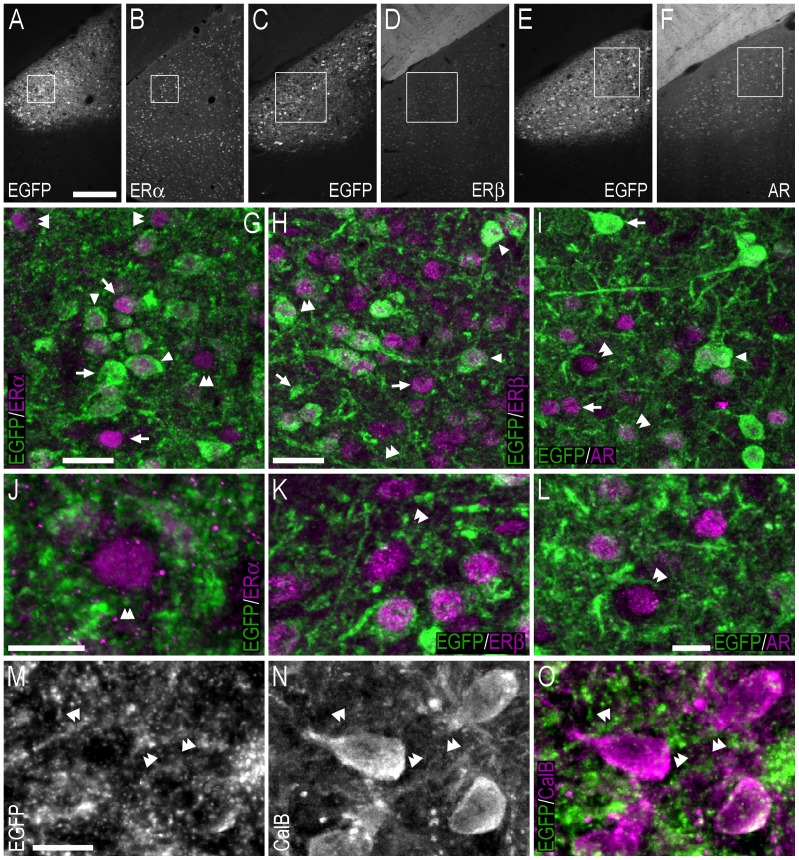
Double-immunofluorescence photo and confocal micrographs showing the distribution of EGFP−, ERα−, ERβ- AR- and calbindin-LI in the medial amygdaloid nucleus – posterodorsal (MePD) part.(A, B) Single-channel photomicrographs of double-fluorescence immunohistochemistry, showing EGFP− (A) and ERα-LI (B) (Bregma, −2.06 mm). (C, D) Single-channel photomicrographs of double-fluorescence immunohistochemistry, showing EGFP− (C) and ERβ-LI (D) (Bregma, −2.06 mm). (E, F) Single-channel photomicrographs of double-fluorescence immunohistochemistry, showing EGFP− (E) and AR-LI (F) (Bregma, −2.06 mm). (G–I) Confocal micrographs of double-immunofluorescence histochemistry displaying (G) EGFP− (green) and ERα-LI (magenta), (H) EGFP− (green), and ERβ-LI (magenta), and (I) EGFP− (green) and AR-LI (magenta). Confocal micrographs in (G), (H) and (I) are magnified views of the white squares shown in (A, B), (C, D) and (E, F), respectively. (J–L) Confocal micrographs of double-immunofluorescence histochemistry displaying (J) EGFP− (green) and ERα-LI (magenta), (K) EGFP− (green), and ERβ-LI (magenta), and (L) EGFP− (green) and AR-LI (magenta). The confocal micrographs in (J, K, L) are magnified views of the immunohistochemistry presented in (G, H, I), respectively. (M–O) Single-channel confocal micrographs of double-fluorescence immunohistochemistry (O), displaying EGFP− (M), and calbindin-LI (N). In G–L and M–O, arrows point to single labelled cell bodies, arrowheads point to double-labelled cell bodies, and double arrowheads point to apparent contacts or close anatomical association between EGFP-ir nerve fibres and single-labelled ERα− (G, J), ERβ- (H, K), AR-(I, L) or calbindin-ir (O) cell bodies. Scale bars: A = 200 µm, applies A–F; G = 20 µm; H = 25 µm, applies H, I; J = 10 µm; L = 10 µm, applies K, L; M = 10 µm, applies M–O.